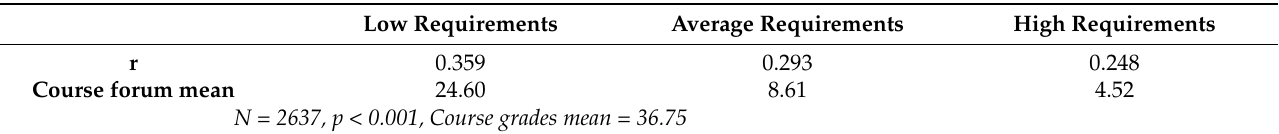
Figure 11. Histogram with the course grades based on summative assessment activities ( x -axis, from 0 to 100) and the number of learners ( y -axis, logarithmic scale). Table 5. Pearson’s correlation coefficient (Learners posting in the course forum AND attempting summative assessment activities).